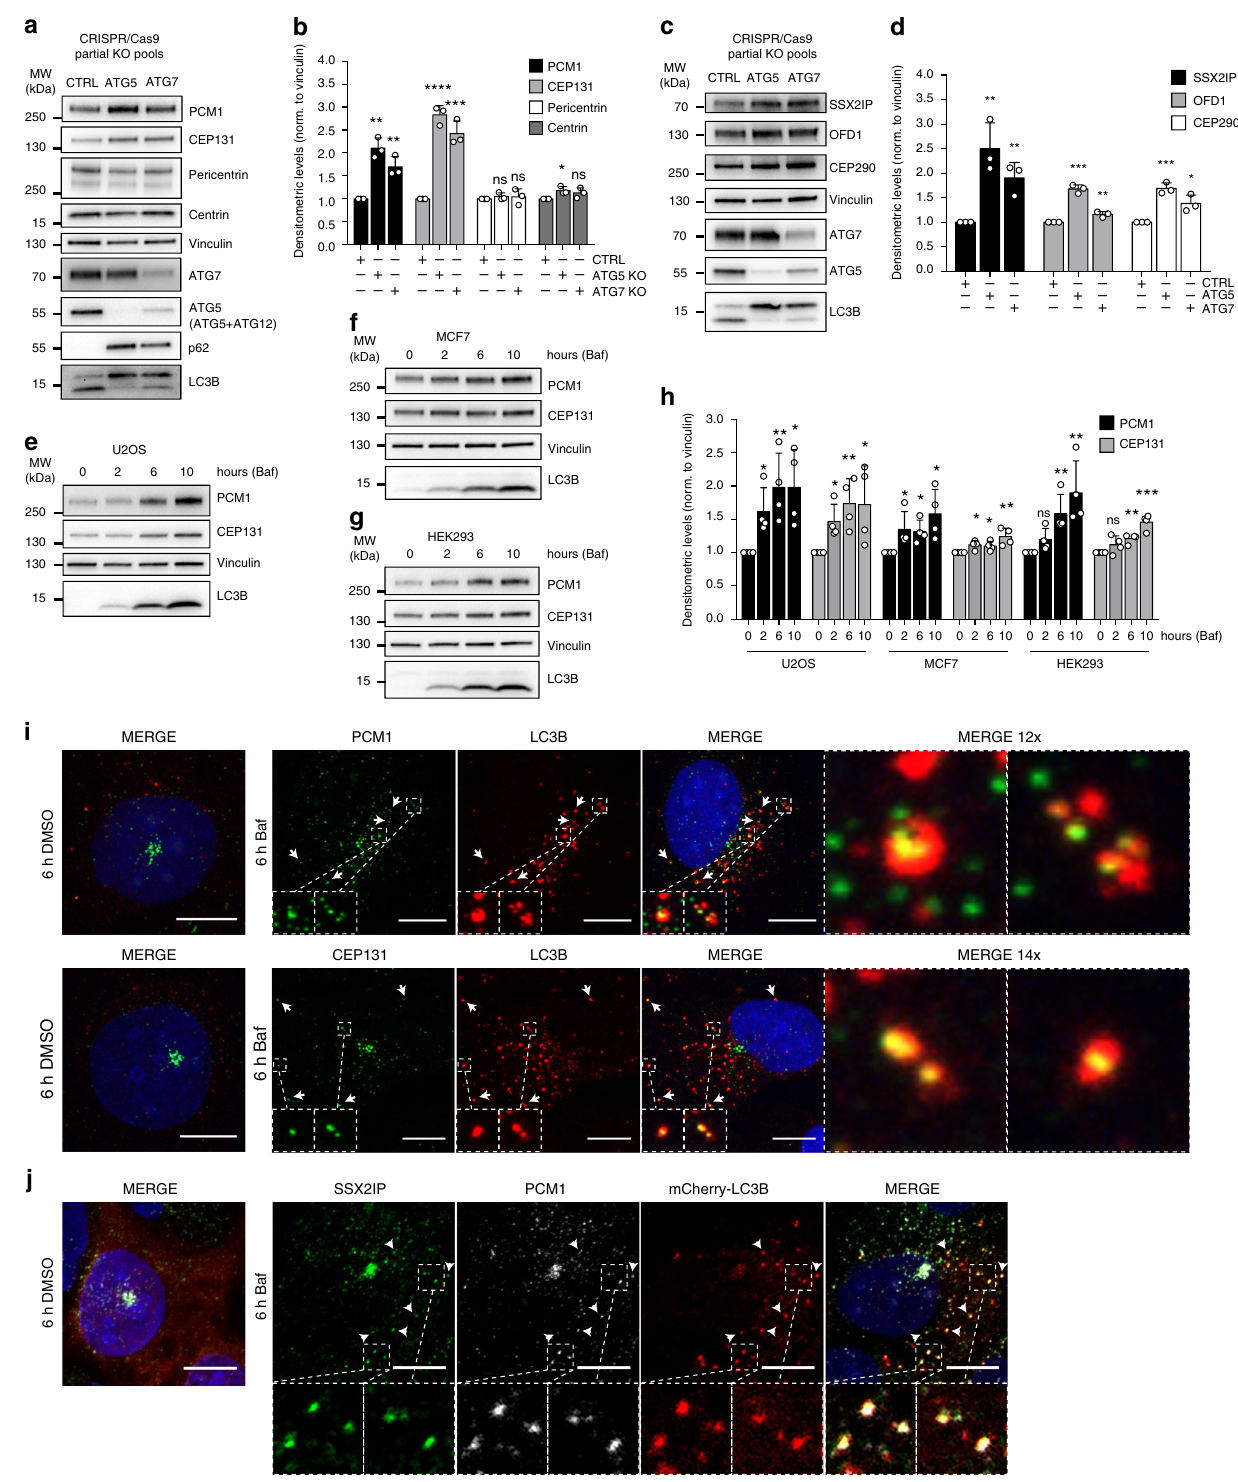
Fig. 7D), con fi rming autophagosomal engulfment of CS sub- strates and indicating that degradation takes place distantly from the centrosome. Importantly, SSX2IP and PCM1 co-localized with the same autophagosomes (Fig. 6j), further supporting that the CS are engulfed as a complex rather than as individual CS protein components. Also, co-localization between PCM1 and endogenous GABARAP or GABARAPL2-positive autopha- gosomes was observed (Supplementary Fig. 7E), as well